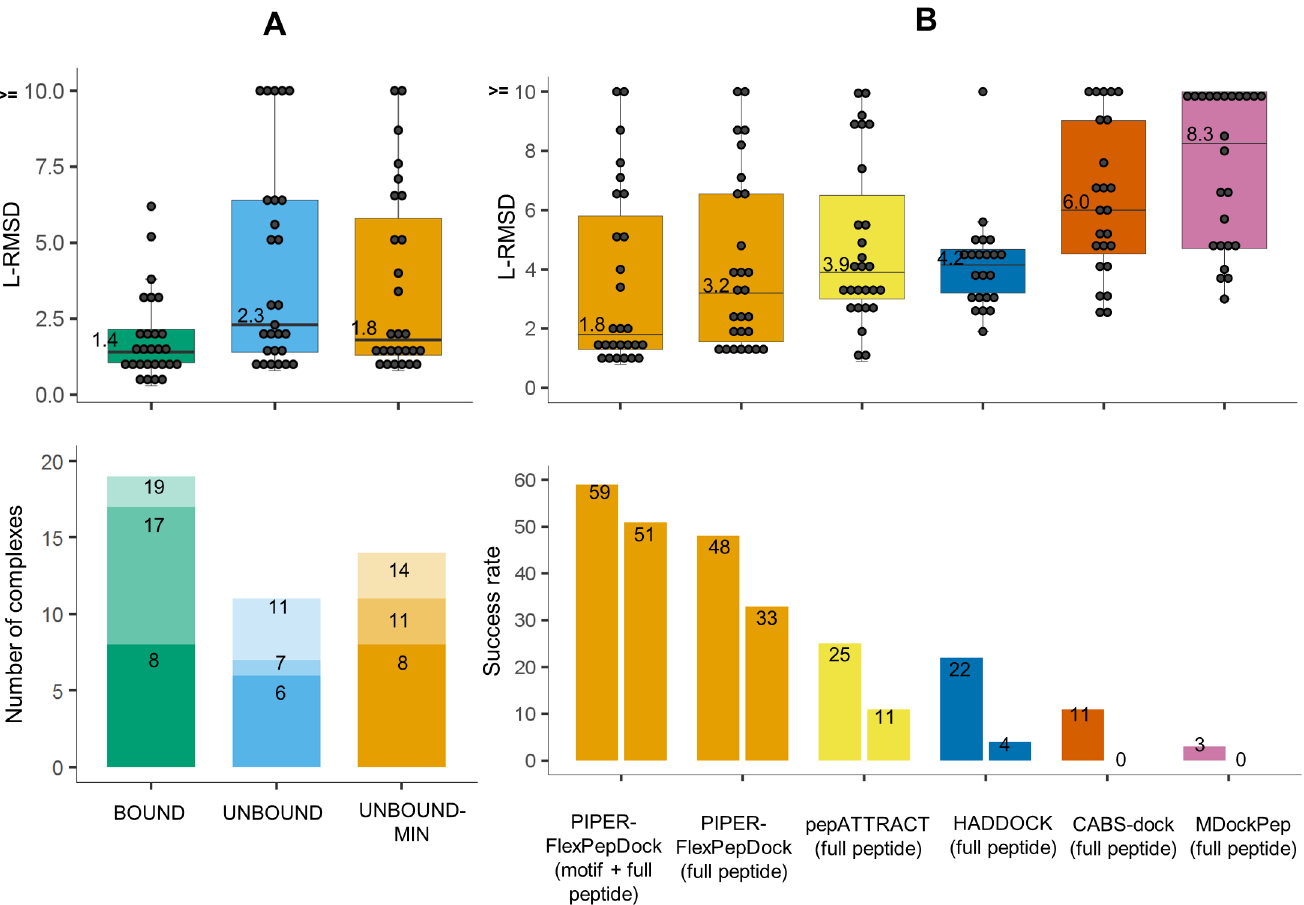
Fig 4. PIPER-FlexPepDock peptide docking performance. (A) Overall performance on a non-redundant set of 27 peptide-protein complexes. Top: Distribution of best model L-RMSDs (among top 10 ranking clusters) for runs using the bound (BOUND) and free (UNBOUND & UNBOUND-MIN) receptor structures, the latter including also receptor flexibility in the final refinement step (only the motif region was modeled for the 12 complexes with known motif). Shown are both the L-RMSD values for each protein-peptide complex (grey circles, rounded values for improved visibility are provided), as well as the distribution (quartiles and medians, with median values printed alongside). Bottom: Distribution of the ranks of the first near-native cluster (defined as L-RMSD < = 2.0 Å ), shown using different shades (for corresponding results among the top1, top3 and top10 ranked predictions). (B) Comparison to performance by other algorithms. Top: Box plots of best L-RMSDs among top 10 ranking clusters, including results for the motif part where the motif is known (as in A), as well as for the full peptide, for comparison. Bottom: Performance is shown for different cutoffs (3.0 Å and 2.0 Å L-RMSD in left and right boxes, respectively) (See S1B Table for more details).